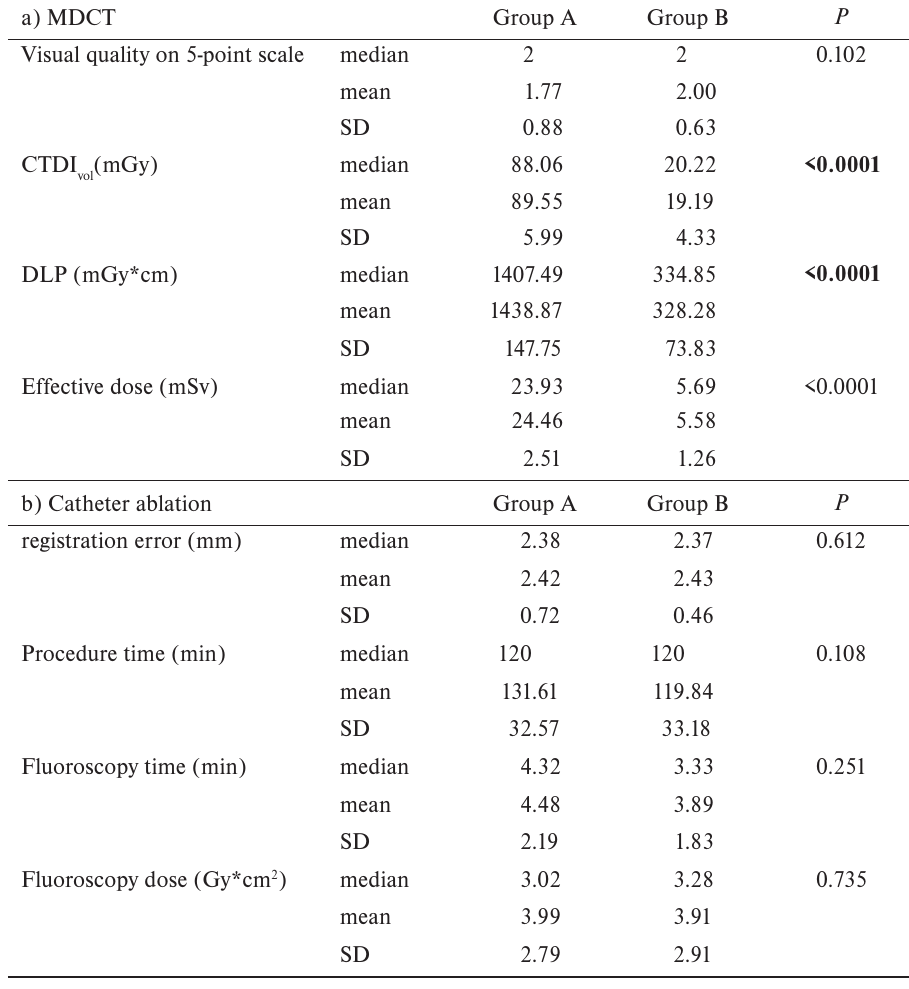
Table 4. MDCT and catheter ablation